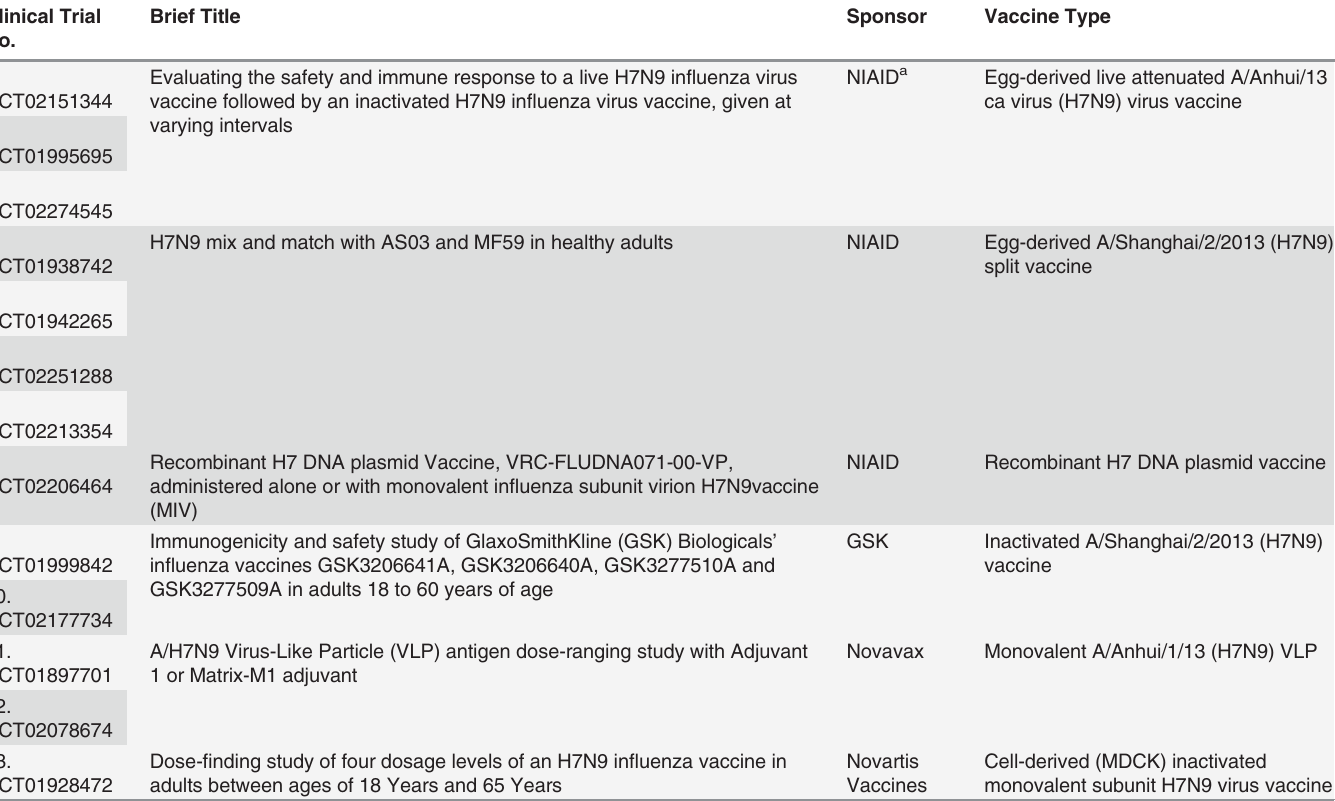
Table 3. Clinical trials of in fl uenza H7N9 vaccines until July 2014. Clinical Trial